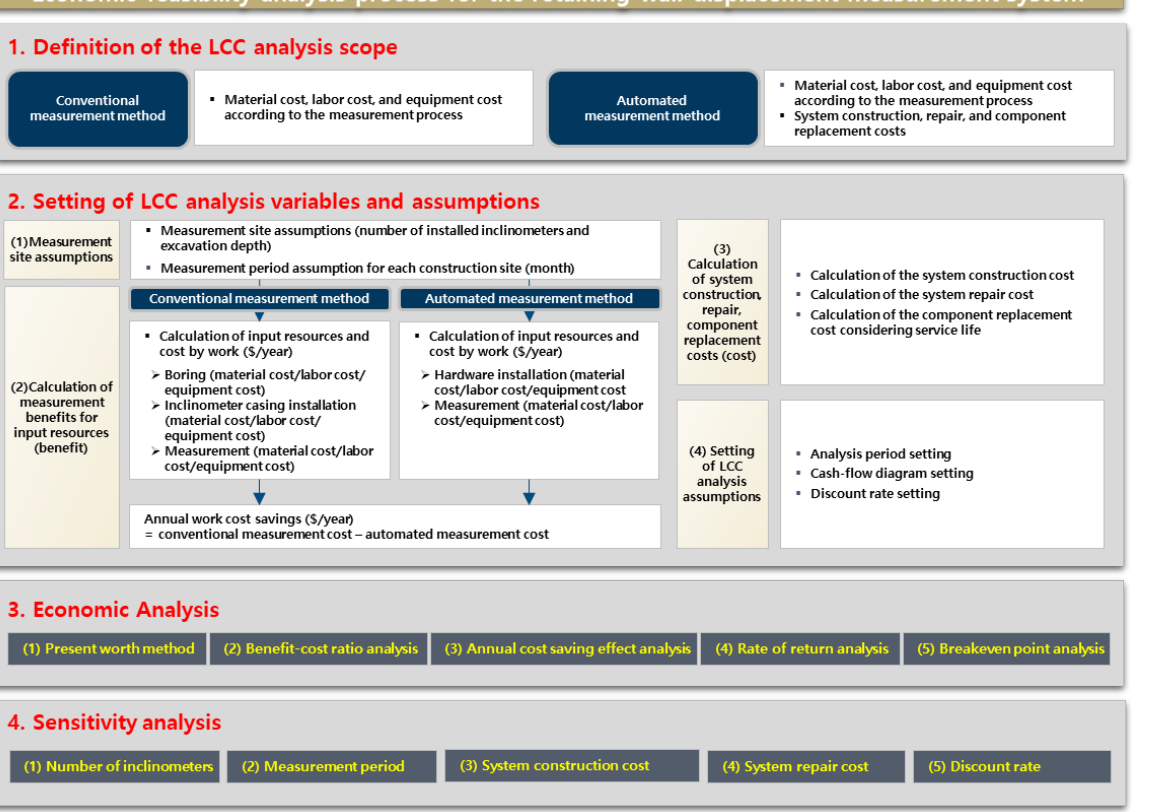
Figure 13. Life cycle cost (LCC) analysis scope.